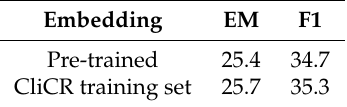
Table 4. The comparison between the CliCR training set embedding and the pre-trained